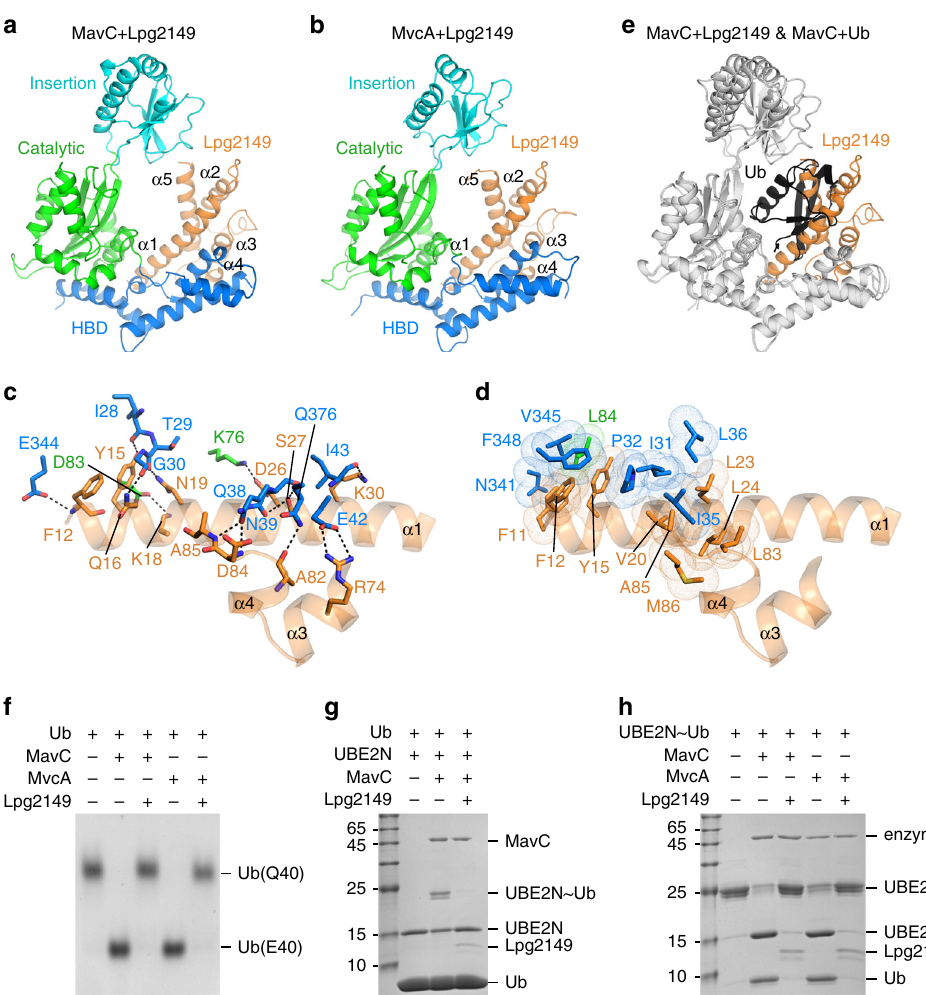
Fig. 5 Structures of Lpg2149 in complex with MavC and MvcA. a , b Overall structures of the Lpg2149 + MavC ( a ) and Lpg2149 + MvcA ( b ) complexes. Lpg2149 was shown in orange. MavC and MvcA has the same color code as in Fig. 1a. c , d Detailed hydrogen bonding ( c ) and hydrophobic ( d ) interactions between Lpg2149 and MavC, with the same color code as in a . e Structural superimposition between MavC + Lpg2149 and MavC + Ub complexes by using MavC (gray) as the reference point. Lpg2149 and Ub were shown in orange and black, respectively. f Lpg2149 can inhibit the Ub deamidation activity of both MavC and MvcA. g Lpg2149 can inhibit the UBE2N ubiquitination activity of MavC. h Lpg2149 can inhibit the UBE2N~Ub deubiquitination activity of both MavC and MvcA. Source data are provided as a Source Data fi le. Experiments in f – h were repeated independently three times with similar